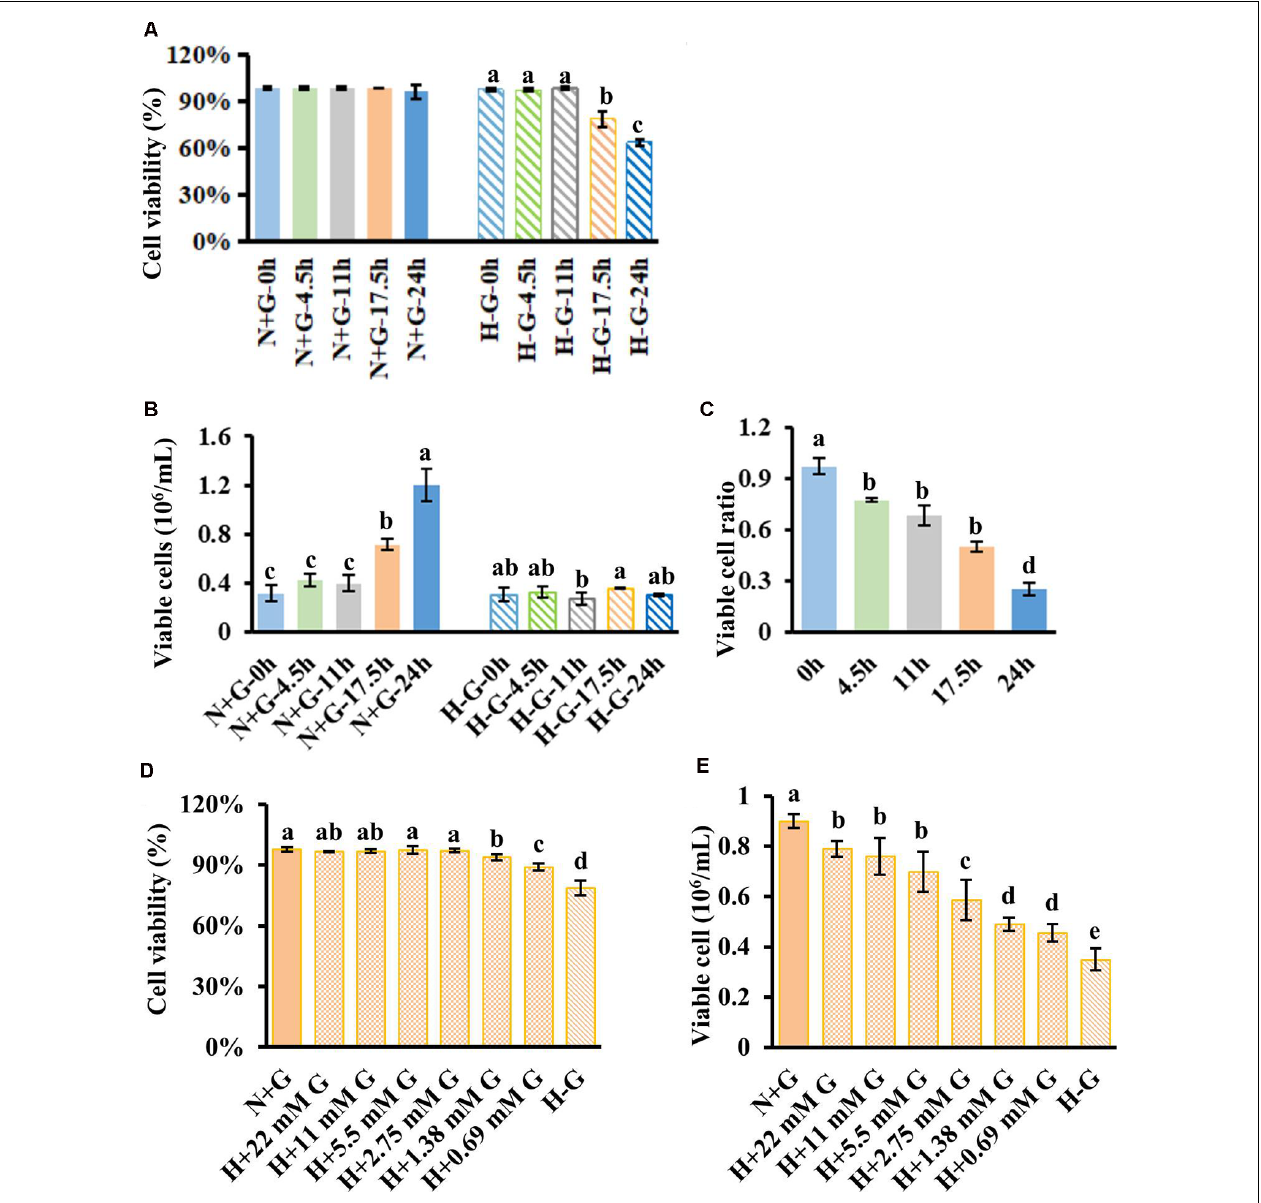
FIGURE 2 | HT22 cell viability and viable cell number under hypoxia along with different concentrations of glucose treatments. Cell viability (A) and viable cell number (B) with its ratio (C) measured at different time points under normoxia with 22 mM glucose (N+G) and hypoxia without glucose (H − G). Cell viability (D) and viable cell number (E) of HT22 cells subjected to hypoxia for 17.5 h with different concentrations of glucose along with N+G and H − G treatments. The viable cell ratio was calculated using viable cells in H − G divided by those in H+G at the same time point. All data plotted are the average of three independent experiments ± SD. One-way ANOVA followed by Fisher’s least significant difference for multiple comparisons was used for statistical analysis. Different letters labeled represent significant differences at p < 0.05 level among